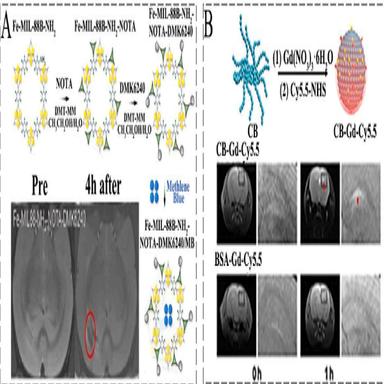
(A) T2-weighted MR images of OA-induced rat after administration of Fe-MIL-88B–NH2-NOTADMK6240 from ref.. Copyright 2020 American Chemical Society. (B) T1-weighted MR images of mice after administration of CB-Gd-Cy5.5 from ref.. Copyright 2018 WILEY-VCH.